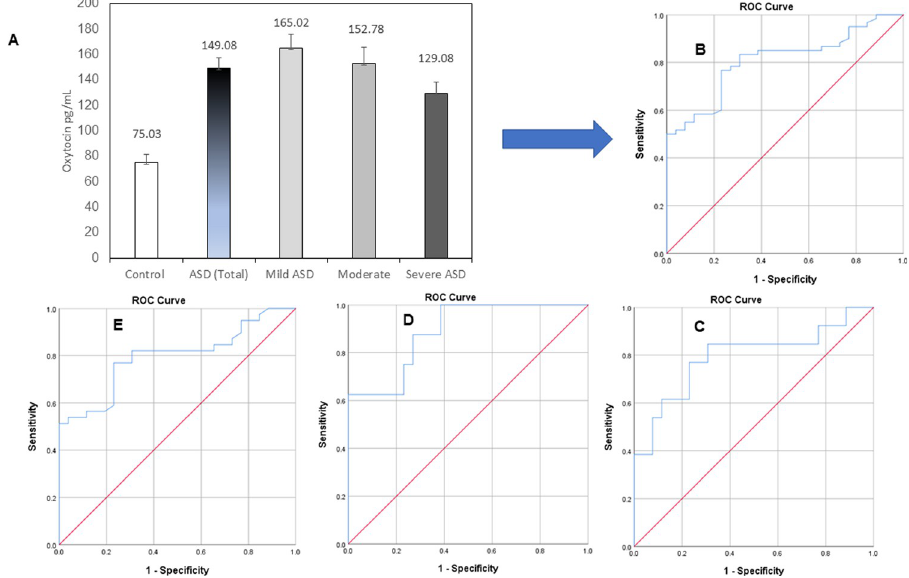
Fig 1. (A) Oxytocin levels among study participants, (B) ROC curve analysis in all ASD cases, (C) ROC curve analysis in mild ASD, (D) ROC curve analysis in moderate ASD, (E) ROC curve analysis in severe